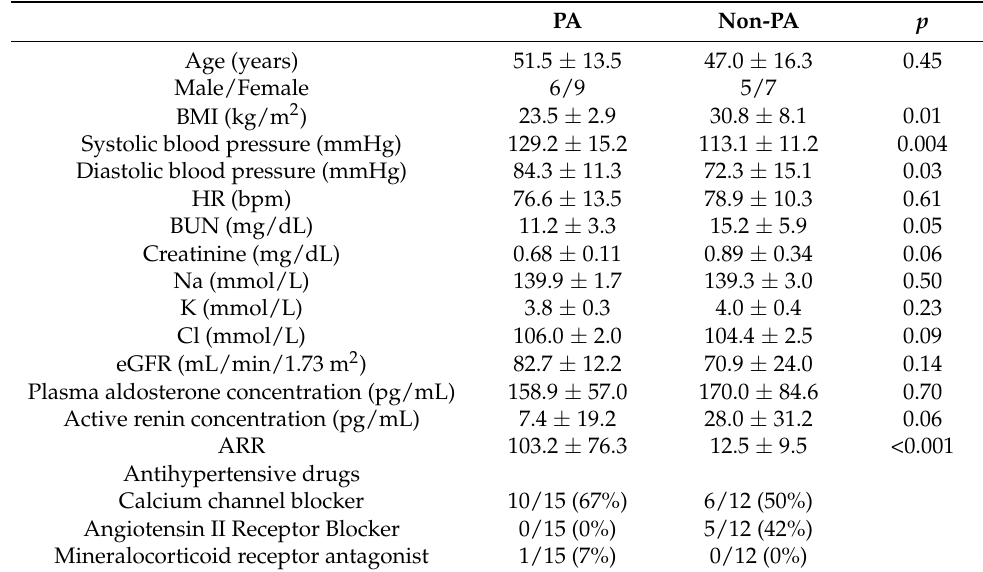
Table 1. Basal clinical characteristics of participants in the